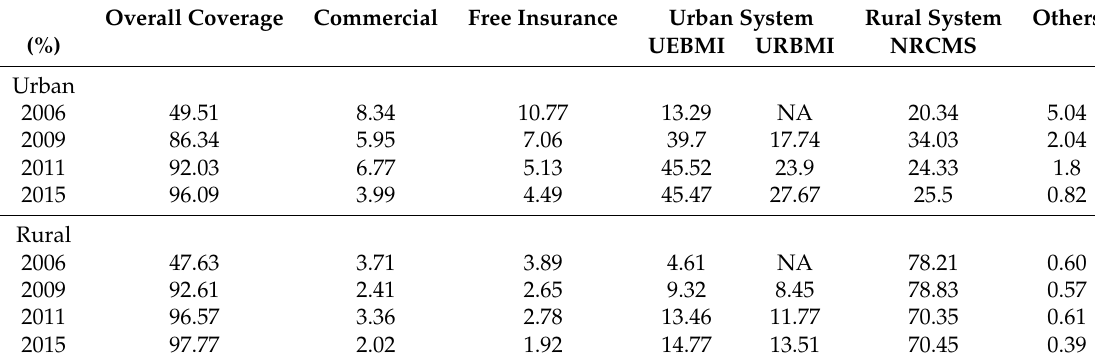
Table 1. The take-up status of health insurance by types and